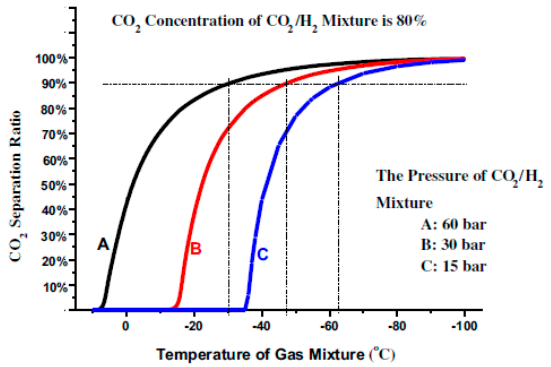
Figure 3. Variation in pressure and separation ratio of CO 2 /H 2 mixture with temperature [8].